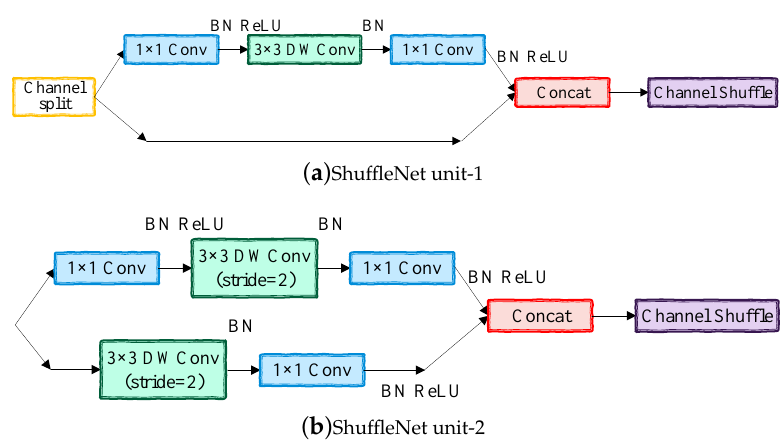
Figure 4. ShuffleNet unit-1 and ShuffleNet unit-2 used in the